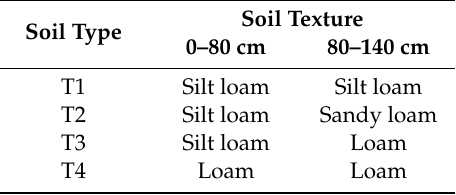
Table 1. The soil types along the soil